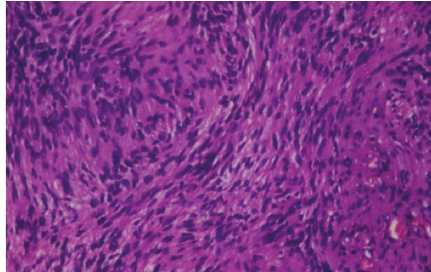
Figure 7: Photomicrograph showing spindle or oval cells in loosely textured matrix (Antoni B areas) (H&E 40x).